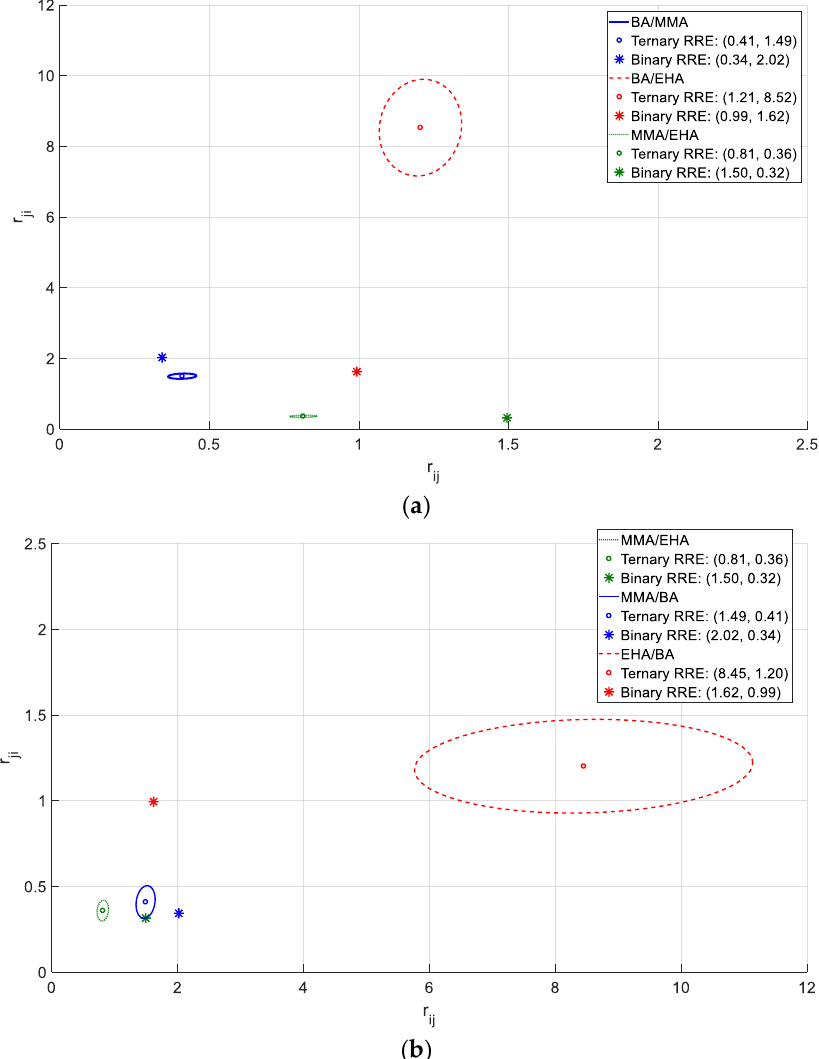
Figure 6. ‘Ternary’ reactivity ratio estimates for the terpolymerization of BA/MMA/EHA for ( a ) M 1 /M 2 /M 3 = BA/MMA/EHA and ( b ) M 1 /M 2 /M 3 = MMA/EHA/BA, with instantaneous data from [12].